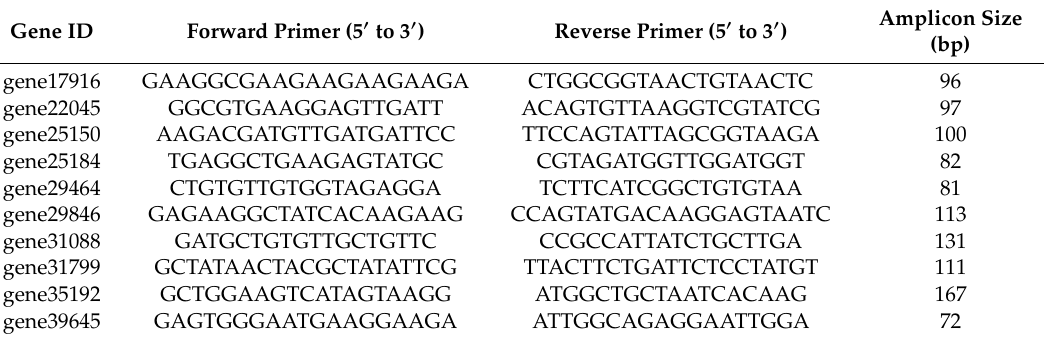
Figure 3. Comparison of differentially expressed genes (DEGs) in seedlings subjected to different acid stresses. ( a ) The x -axis represents each comparison treatment, and the y -axis presents the gene number. The red color indicates upregulated genes, and the purple color indicates downregulated genes. ( b ) A Venn diagram shows the overlap between DEGs that are responsive to acid stress treatments. ( c ) the gene expression patterns and cluster analysis results of twelve samples are shown. The red / blue color on the far right indicates the up / down regulated DEGs of each sample. Table 2. Primers for qRT-PCR assays used for the twelve RNA-seq libraries in this study.